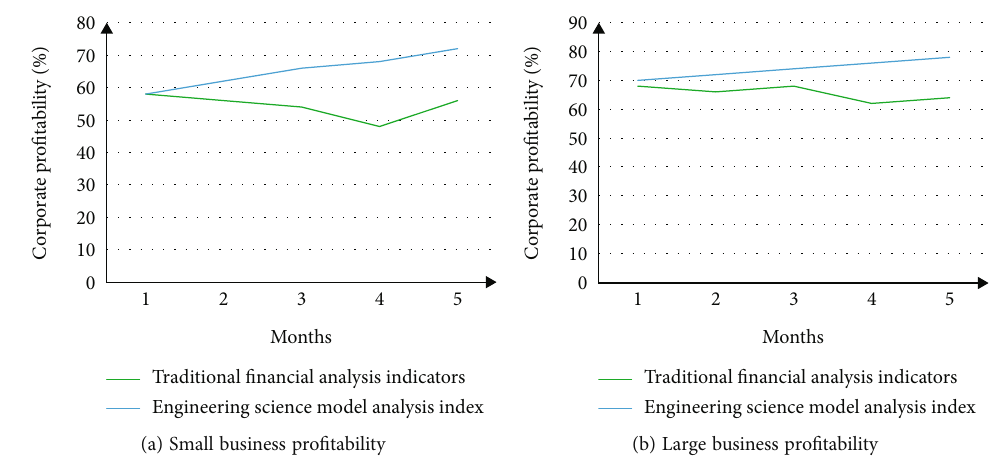
Figure 6: Comparison results of corporate pro fi